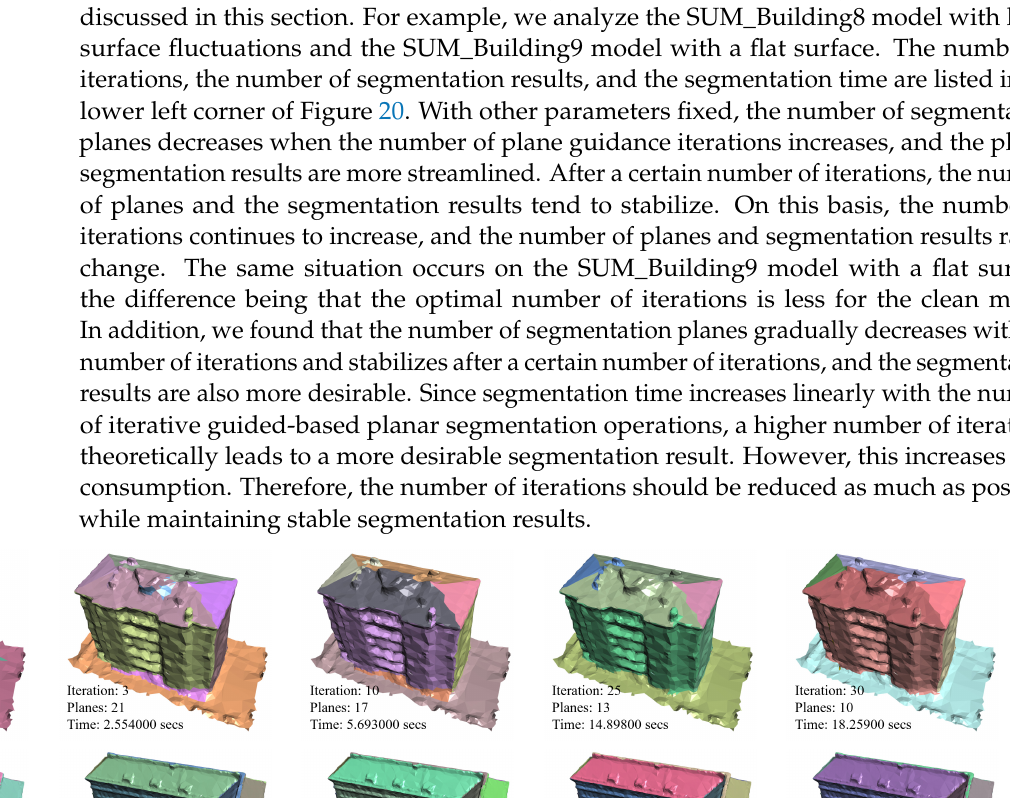
Figure 19. Comparison of polyhedral results with the original point cloud.